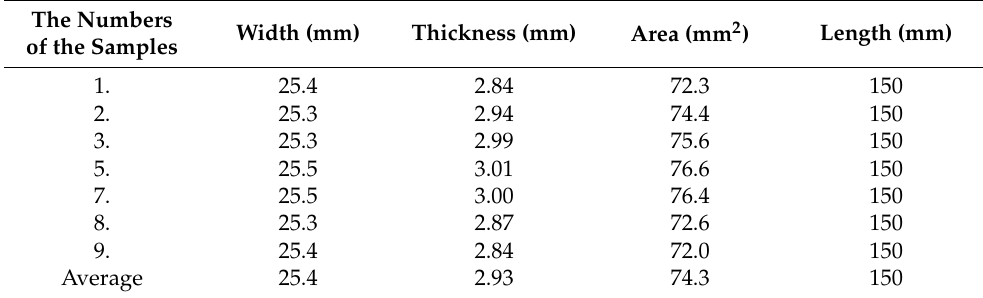
Table 6. Geometric dimensions of composite samples reinforced with the symmetrical Interglas 02037 fabric.